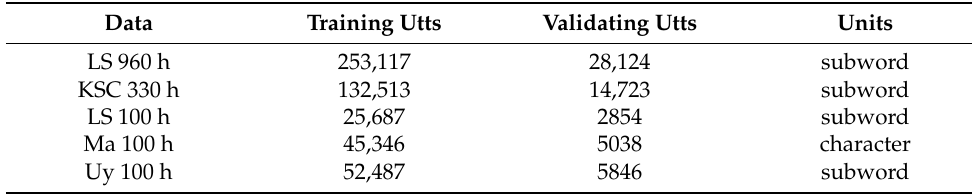
Table 3. Specification of data sets for each